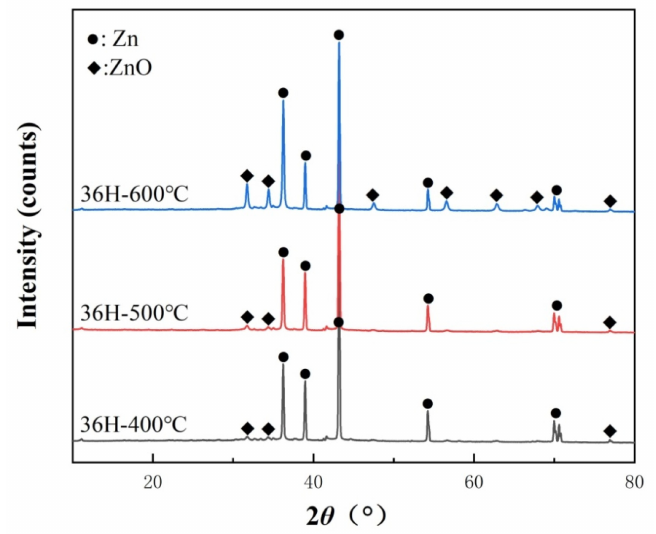
Figure 8. XRD patterns of the stored WB zinc-based coatings treated at different